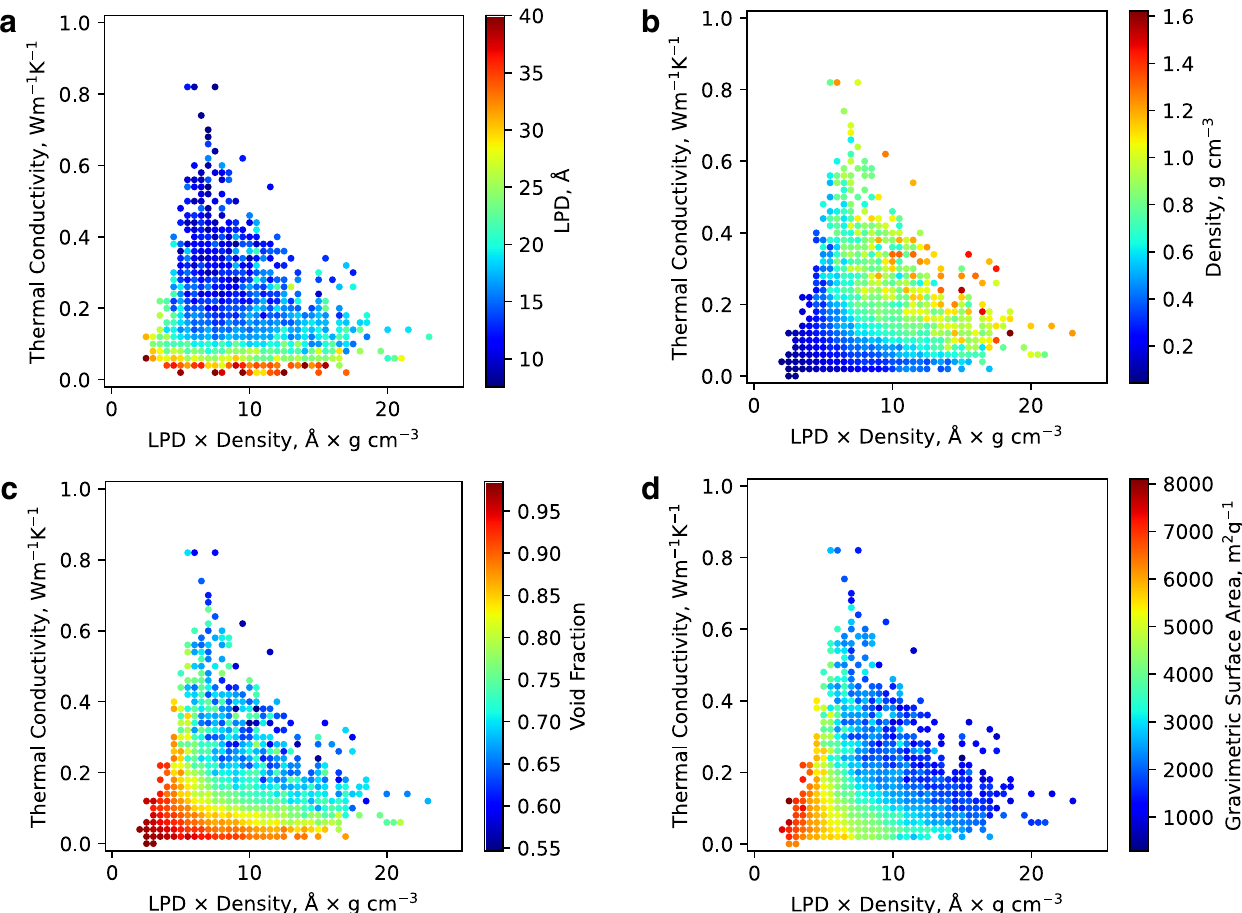
Fig. 4 Relationship between thermal conductivity and the product of the density and the largest pore diameter (LPD). Figure panels are colored by a LPD, b density, c void fraction, and d gravimetric surface area. Each plot is divided into 50 × 50 bins which are illustrated by a fi lled circle, whose color represents the averaged property across all MOFs in that bin. Bins with less than three structures are not shown to reduce